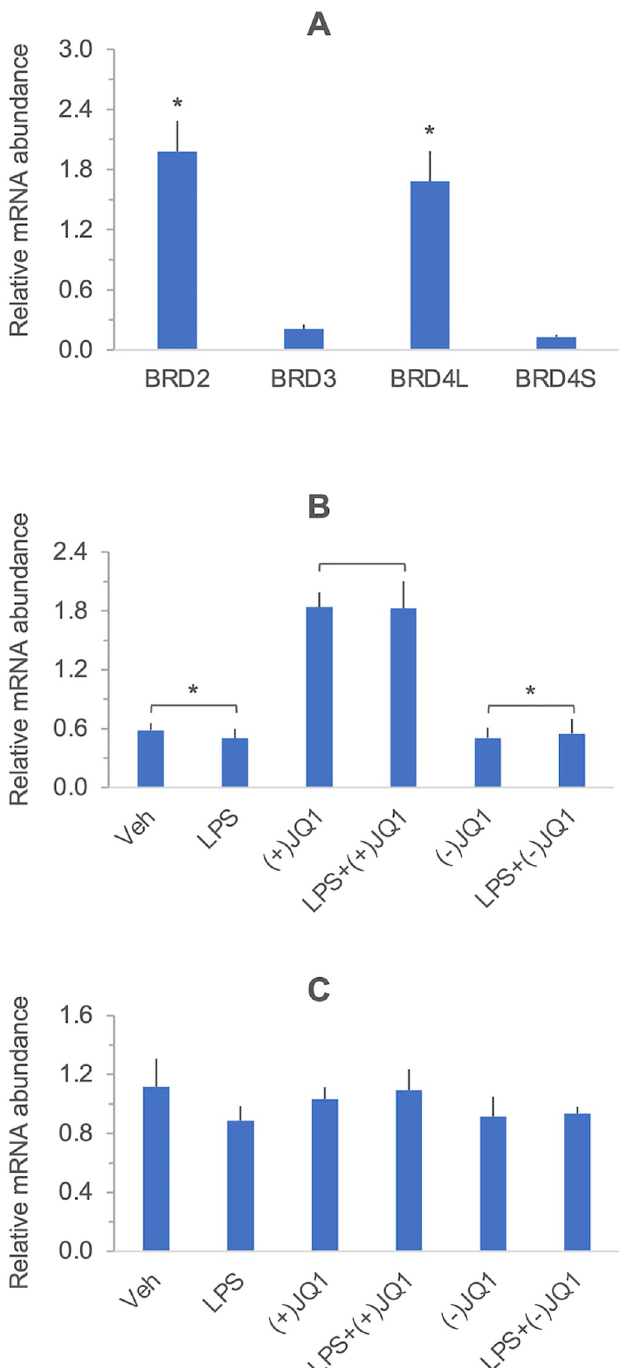
Fig 5. Expression of BET family members in DSCs. Total RNA was extracted from primary DSC cultures and mRNA levels encoding BRD2, BRD3, BRD4S and BRD4L were determined by qRT-PCR. (Panel A ) Columns represent the mean ± SEM of n = 6 independent experiments. � , p < 0.05 vs . BRD3 and BRD4S, by Dunn’s test (non- parametric) with Bonferroni correction for multiple comparisons. Panels B and C : The effect of (+)-JQ1, (-)-JQ1, and LPS on BRD2 and BRD4L expression, respectively. Cultures were treated with drugs and LPS, as described in the Materials and methods. Messenger RNA levels were determined by qRT-PCR. Columns represent the mean ± SEM of n = 4–9 independent experiments. LPS did not affect BRD mRNA levels (p > 0.05, Wilcoxon’s signed-rank test), and drug effects were evaluated after pooling data with LPS- treated and LPS-untreated cells. � , p < 0.05 vs . (+)-JQ1